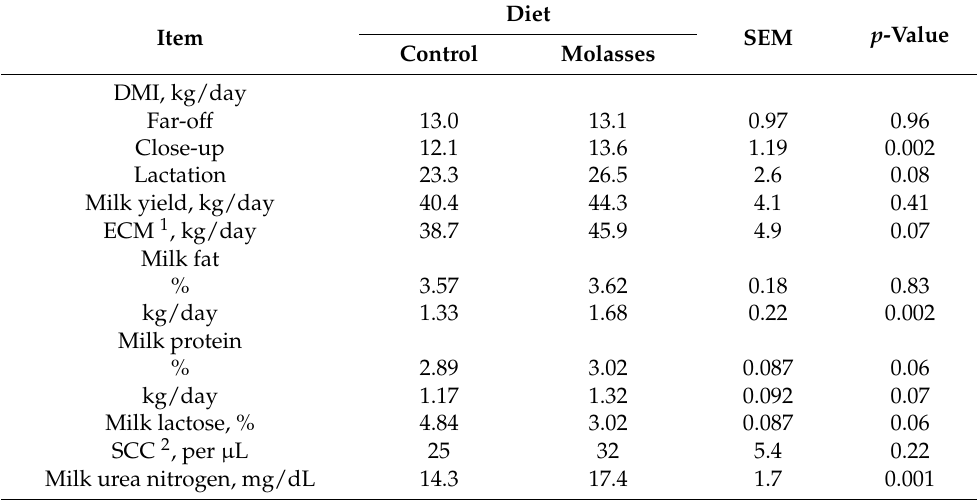
Table 7. Dry matter intake (DMI) and milk yield and composition during the initial 60 day of lactation for cows fed control or molasses-containing diets during a 60 day dry period (Experiment 2). Diet Item